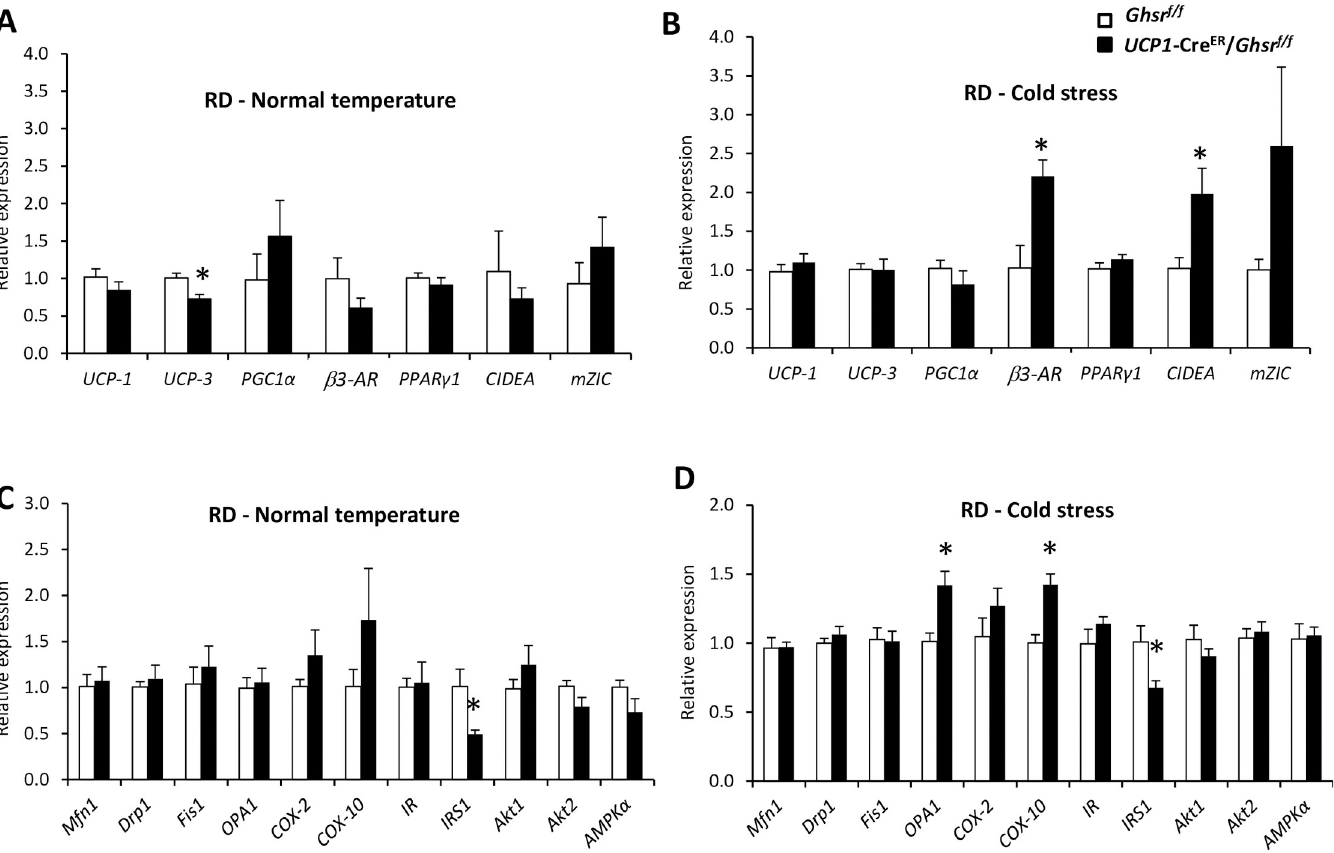
Fig 3. Gene expression profile of BAT in RD-fed mice. BAT from 20-week old male RD fed Ghsr f/f and UCP1 -Cre ER / Ghsr f/f mice were collected either under normal housing temperature or after 6 h of 4˚C cold exposure. ( A ) Thermogenic-related gene mRNA expression levels in the BAT under normal housing temperature. ( B ) Thermogenic-related gene mRNA expression levels in the BAT under 4˚C cold exposure. ( C ) Mitochondrial and insulin signaling related gene mRNA expression levels in the BAT under normal housing temperature. ( D ) Mitochondrial and insulin signaling related gene mRNA expression levels in the BAT under 4˚C cold exposure. All data were expressed as the mean ± SEM. n = 3–6, � P < 0.05, Ghsr f/f vs . UCP1 -Cre ER / Ghsr f/f